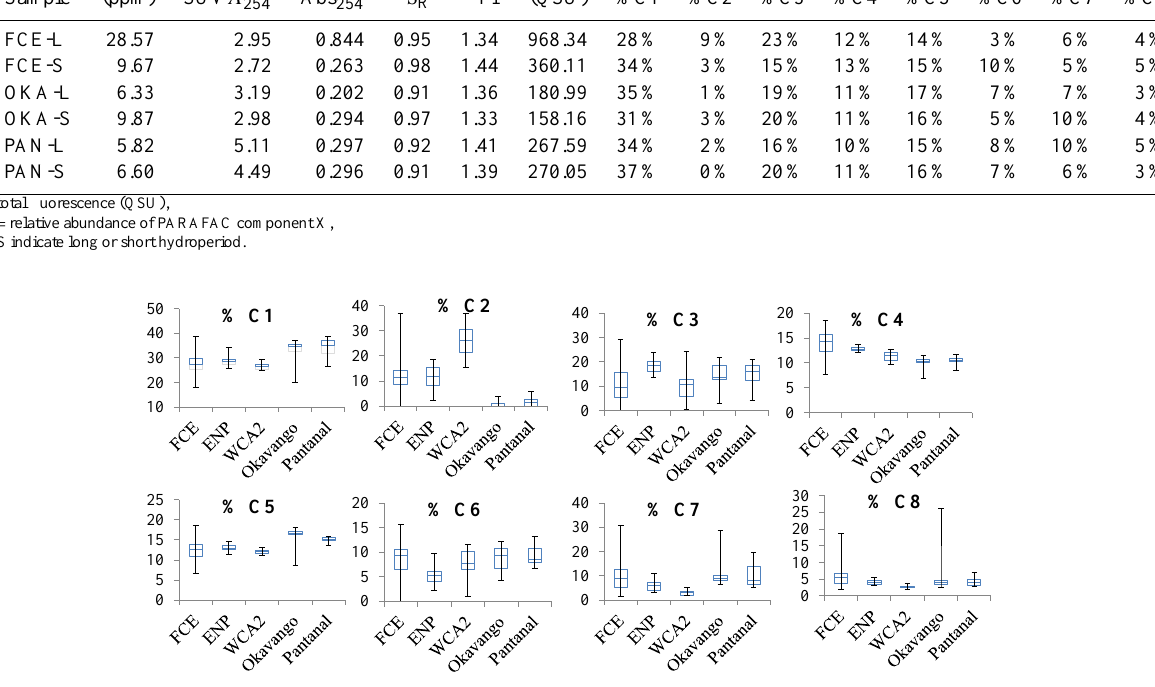
Figure 1. Box plots of the relative abundance (%) of PARAFAC components for the Florida coastal Everglades (FCE), Okavango (OKA) and Pantanal (PAN) regions. Top of the blue box represents the 75th percentile, middle of the blue box is the median, lower edge of blue box is the 25th percentile, top of the black bar is the maximum value, and bottom of the black bar is the minimum value. ENP = Everglades National Park; WCA2 = Everglades Water Conservation Area